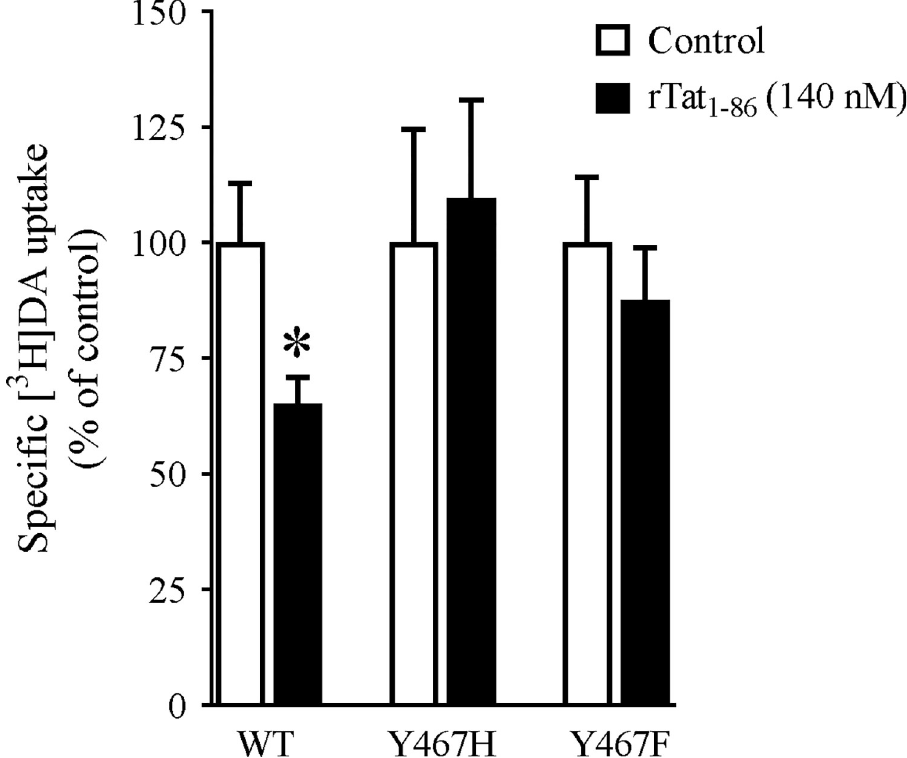
Fig 3. Effects of Tat 1-86 on the specific [ 3 H]DA uptake in WT-, Y467H-, and Y467F-hNET. PC12 cells transfected with the WT hNET or mutants were preincubated with or without recombinant Tat 1-86 (rTat 1-86 , 140 nM, final concentration) at room temperature for 20 min followed by the addition of [ 3 H]DA (50 nM, final concentration) for an additional 8 min at room temperature. In parallel, nonspecific uptake was determined in the presence of 10 μ M desipramine. Data are expressed as means ± S.E.M. from 4–9 independent experiments. � p < 0.05 compared to control value (in the absence of Tat, unpaired Student’s t test). Mutational effects of hNET on basal [ 3 H]dopamine and [ 3 H]MPP + efflux To further determine the effects of the mutations of Tyr467 residue on hNET on transporter conformational transitions, we examined the fractional efflux levels of [ 3 H]DA and [ 3 H]MPP + in WT hNET and its mutants. As shown in Fig 4A, after 20-min preloading 50 nM [ 3 H]DA, cells were washed and initial fractional efflux samples were immediately collected as 0 time point. While the efflux peak of [ 3 H]DA was observed at 10 min in WT hNET and mutants, there was no difference in the efflux between WT hNET and mutants. With regards to the efflux of [ 3 H]MPP + (Fig 4B), a two-way ANOVA revealed significant main effects of mutation (F = 5.4; p < 0.05), time (F = 140.8; p < 0.001), and time × mutation (F = 2.0, (2, 6) (10, 60) (20, 60) p < 0.05) for Y467F and Y467H when compared to WT hNET. Post-hoc analysis with a simple comparison for Y467F vs WT hNET revealed significant main effects of mutation (F = (1, 4) 20.8, p < 0.05), time (F = 110.5, p < 0.001), and time × mutation (F = 3.527, (10, 40) (10, 40) p < 0.005) suggesting that overall efflux in Y467F was significantly reduced across 110 min. No difference in the efflux was observed between Y467H and WT hNET. These data support our findings that Y467F alters the conformation of the transporter, and additionally suggest that the Y467F mutation reduces the capability of the transporter to undergo efficient confor- mational transitions.